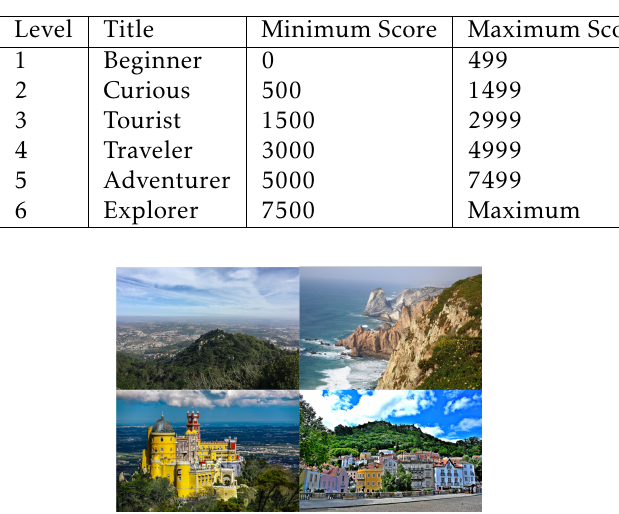
Table 2. Explorer levels - Maximum is equal to the maximum integer that can be represented with 32bits.